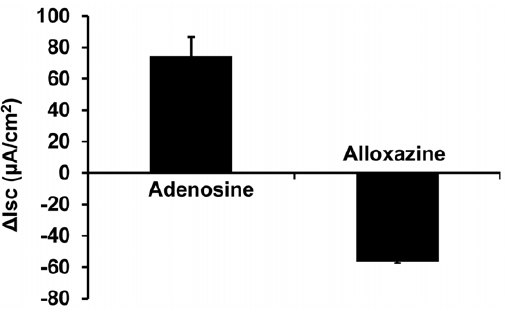
Figure 4. Adenosine stimulates chloride conductance through the A 2B adenosine receptor (A 2B AR). The air-liquid interface cultures of Calu-3 cells were stimulated with 100 m M of apical adenosine, followed by apical addition of 50 m M of alloxazine, a specific inhibitor for A 2B AR. The adenosine-stimulated I SC was decreased by , 75% (n=6).